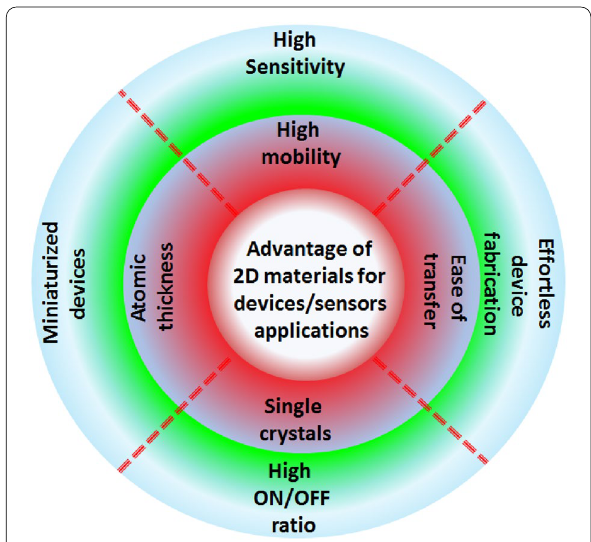
Fig. 10 Salient advantages of 2D materials for device/sensing applications